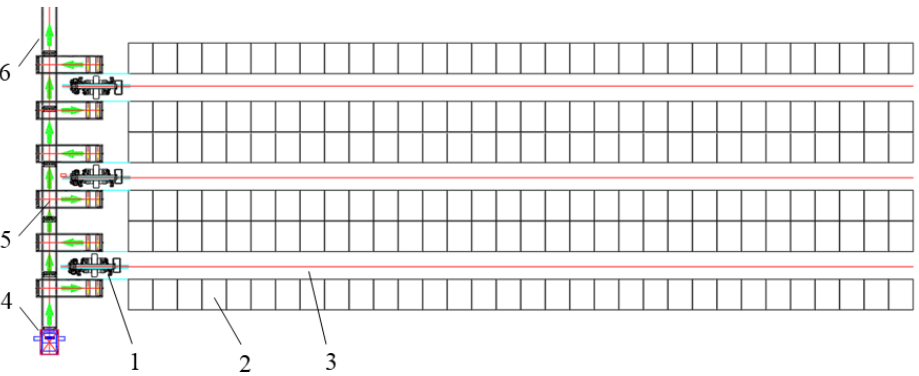
Figure 1. Layout schematic diagram of AS/RS. 1. Crane. 2. Rack. 3. Aisle. 4. Input point. 5. Conveyor. 6. Output point.